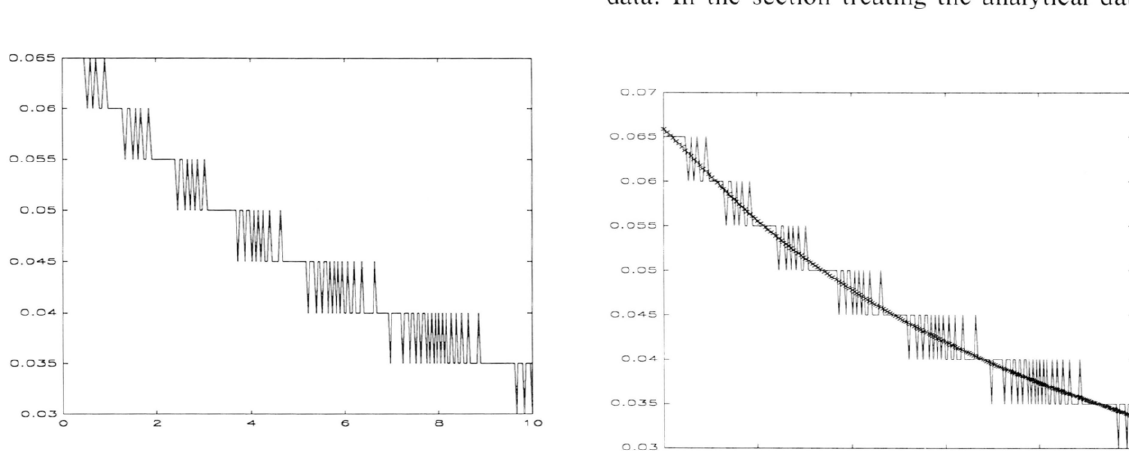
FIGURE 3 Period estimate with coarse sampling (LlI) .